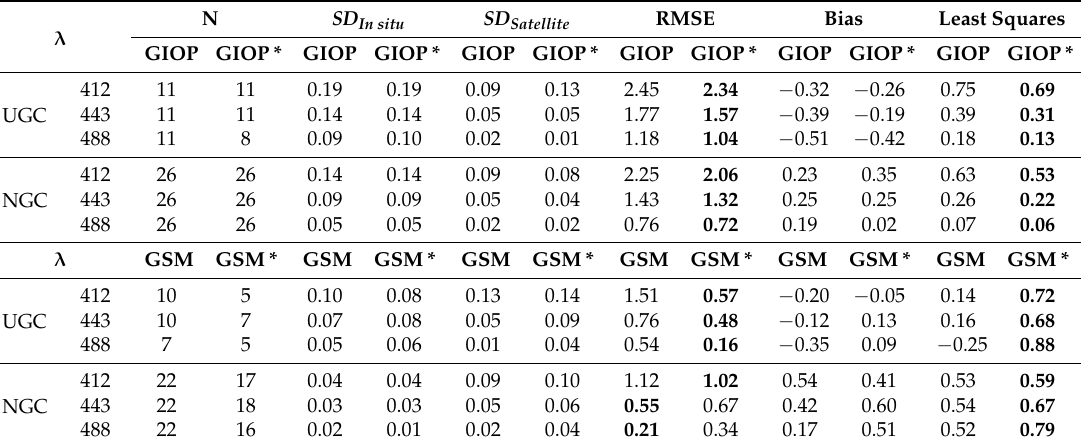
Figure 10. ( a ) In situ S dg variability for all cruises analyzed in this study, including the value used in GIOP ( S dg = 0.018, black dotted line) and GSM ( S dg = 0.02061, gray dotted line). Also indicated are the frequency histograms for ( b ) UGC and ( c ) NGC. Table 4. Comparison between statistics applied to the in situ absorption coefficient a dg ( λ ) and the outputs of the models in their default configurations (GIOP, GSM), and the outputs after adjustment with the in situ S dg values (GIOP *, GSM *). The lowest values of RMSE and Least squares are indicated in bold letters.